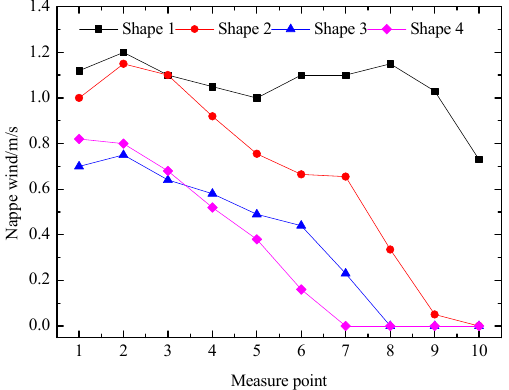
Figure 11. Nappe wind at the upstream slope in the physical model test.